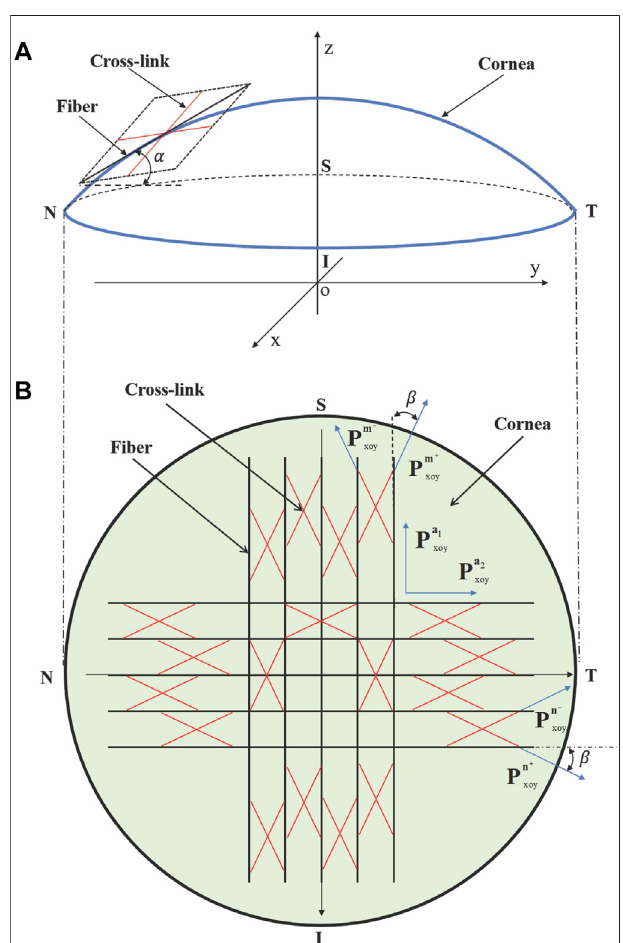
FIGURE1|(A) Sideviewand (B) anteriorviewofthecornealstromawith two families of fi bers and corresponding cross-links. α is the angle between thelocalized fi bersandhorizontalsurface.Cross-linksdistributesymmetrically with respect to the collagen fi bers with an angle of β on the projection plane (i.e., the x-o-y plane). P a 1 xoy , P a 2 xoy , P m ± xoy and P n ± xoy are the vectors for fi bers and cross-links on the projection plane,